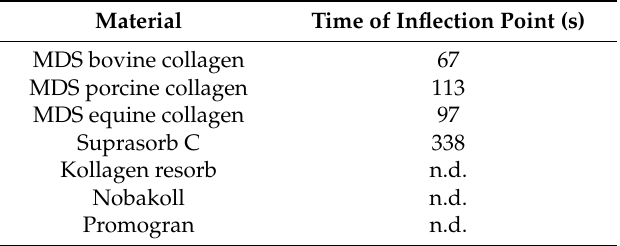
Table 1. Inflection points of platelet aggregation curves. (n.d.: not detectable). Material